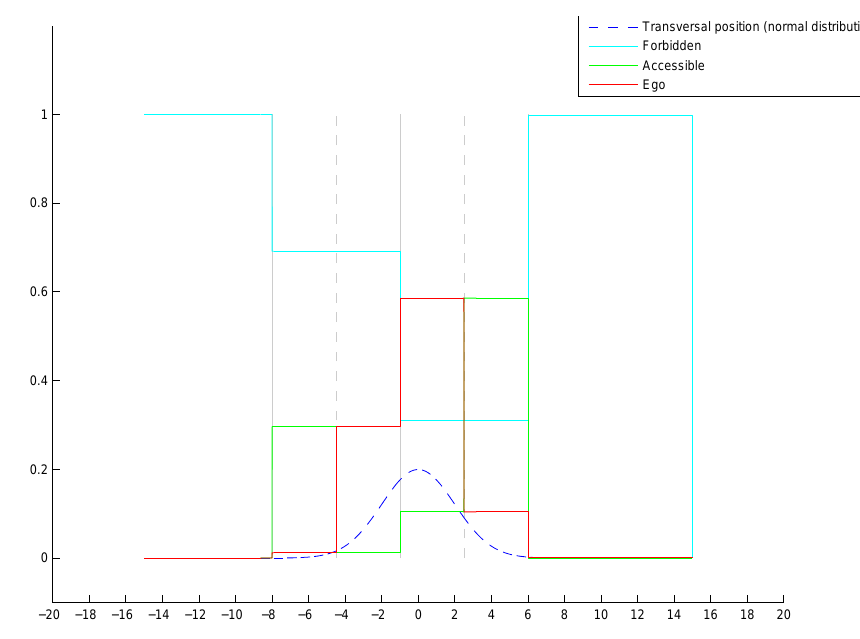
Figure 7. Final lane belief